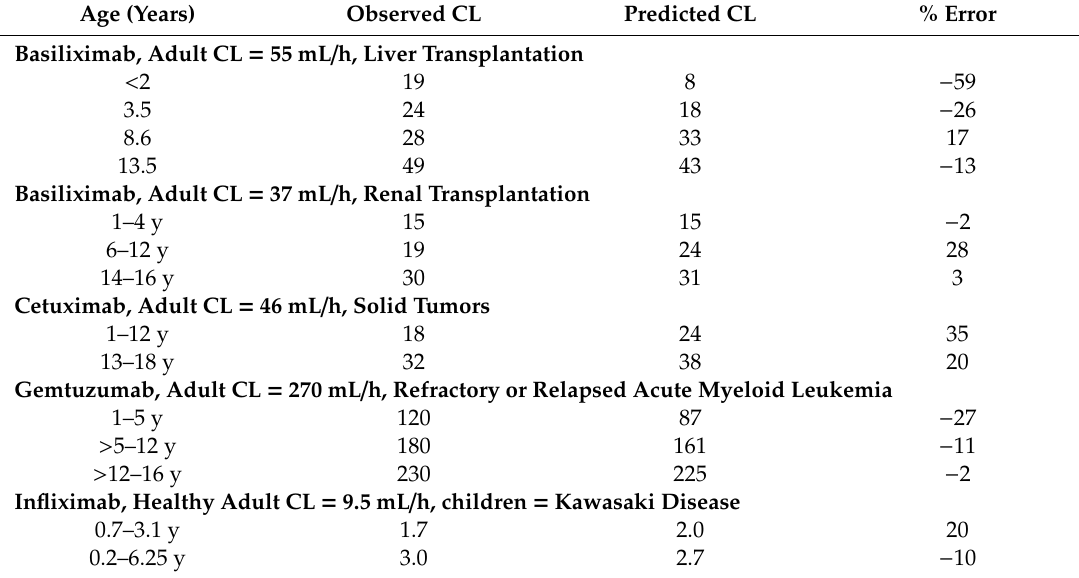
Table 1. Predicted and observed clearance of monoclonal antibodies in children of di ff erent ages. Age (Years) Observed CL Predicted CL %